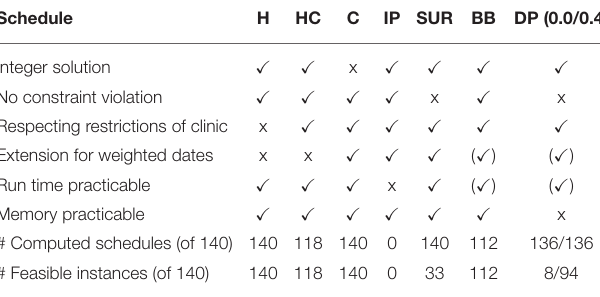
TABLE 6 | Summary of relevant properties of the investigated methods for generating treatment schedules.